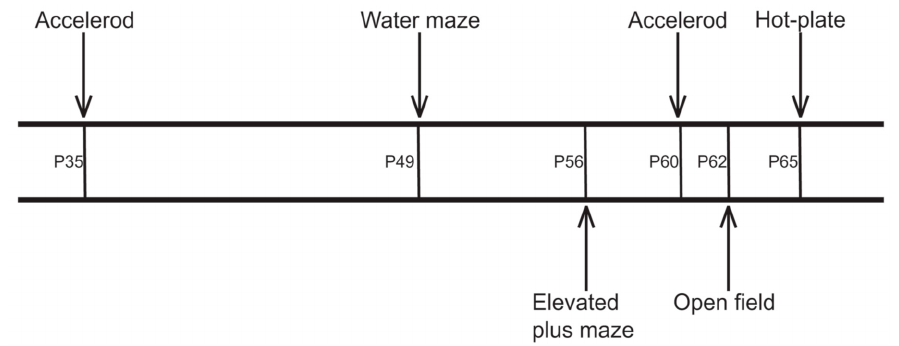
Figure 7. Time points of behavioral tests. P—postnatal day.